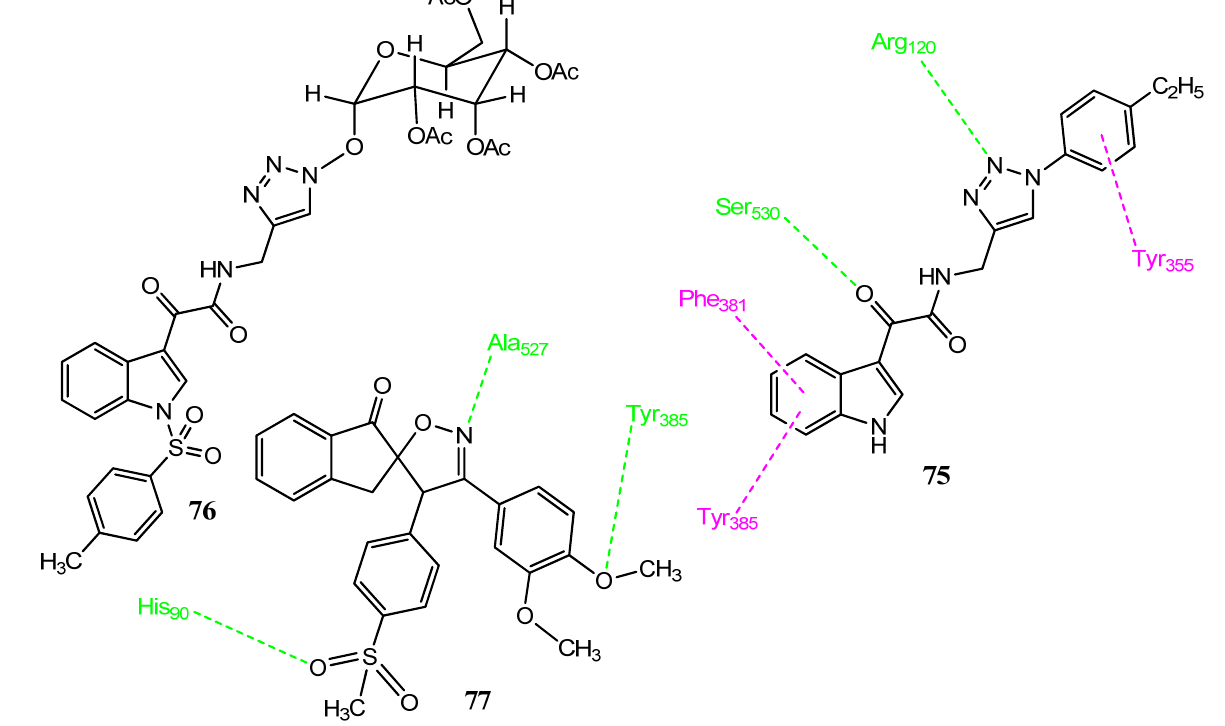
Figure 16. Indole- and indanone-based molecules.